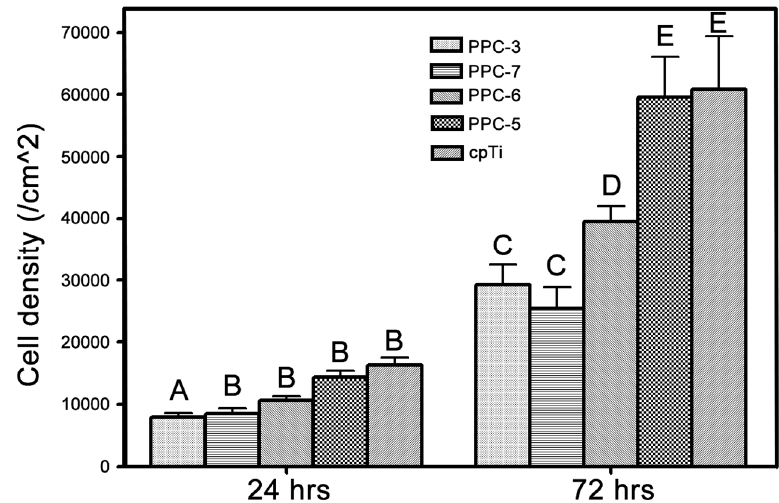
Figure 11. The cellular attachment test after 24 h of incubation and the cellular proliferation study after 72 h of incubation. Hemocytometry suggested that polymer coating could achieve a similar cell confluency as the conventional titanium surfaces. Each letter represents an individual statistical group. (One way ANOVA, p >